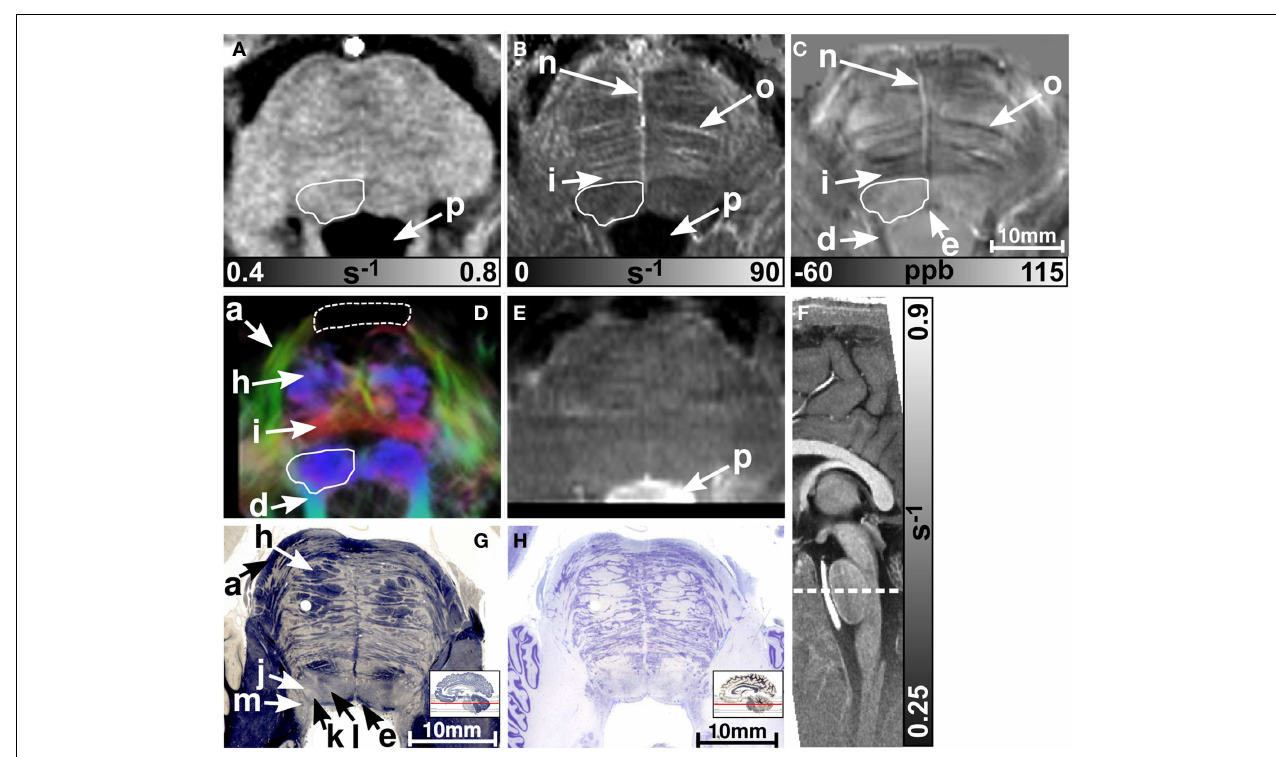
(i) pontocerebellar tract, (j) facial nucleus, (k) salivatory nucleus, , and FIGURE 4 | Images of the middle part of the pons . R 1 , R ∗ 2 (l) abducens nucleus, (m) solitary nucleus, (n) vein, (o) fiber bundle that susceptibility maps as well as track-density (same color-encoding as in traverses the pons in medial to lateral direction, and (p) fourth ventricle Figure 1 ; slightly distorted compared to the other axial image contrasts) (cerebrospinal fluid).The solid white outline in (A–D) summarizes the and T 2 -weighted images of the same region are presented in axial caudal part of the pontine reticular nucleus, the facial nucleus, salivatory orientation from (A–E) , respectively.The sectional plane of the axial nucleus, and abducens nucleus.The dashed white outline in (D) indicates a images is indicated by the dashed line overlaid on the sagittal R 1 map region between the middle cerebellar peduncle that could not be resolved shown in (F) . Axial histological sections from a different subject stained for withTDI. [The histological stains (G,H) were adapted with permission from myelin and cells are illustrated in (G) and (H) , respectively.The arrows in http://www.brains.rad.msu.edu and http://brainmuseum.org, supported by the images indicate: (a) middle cerebellar peduncle, (d) superior cerebellar the US National Science peduncle, (e) medial longitudinal fasciculus, (h) corticospinal fibers,